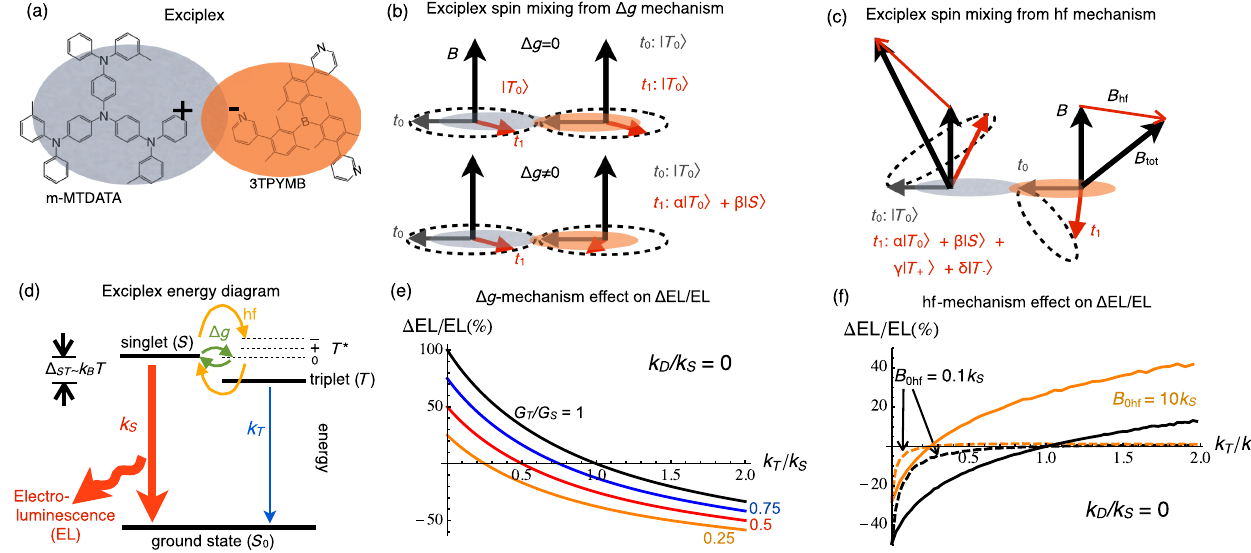
FIG. 1. Exciplexes, Δ g mechanism, and hyperfine mechanism for magnetic field effects. (a) Schematic of the exciplex with m- MTDATA as the donor and 3TPYMB as the acceptor. The electron (hole) wave function is schematically represented by the orange (gray) oval and is overlaid upon the respective chemical structures. (b) Δ g spin mixing between the electron and hole spins (shown to be orthogonal to the applied field B ) which are initiated at time t 0 in the j T 0 i spin configuration. In the top panel, where there is no difference in g factors, the spins remain in their initial configuration. In the lower panel, with nonzero Δ g , the spinor picks up singlet ( j S i ) character over time t 1 . (c) As in (b), but hyperfine spin mixing between electron and hole spins. In this case, spin mixing occurs among all four spin states. (d) Energy diagram of exciplex showing the exchange splitting Δ between the singlet and triplet levels. For efficient TADF, Δ ST ST T . The much quicker singlet recombination (with rate k should be similar in magnitude to the thermal energy k ) is depicted by the thicker B S arrow compared to triplet recombination (with rate k ) and luminescence is assumed only for the singlet recombination. Spin mixing T occurs due to the Δ g mechanism (i.e., transitions between S and the activated T 0 level of T (cid:2) ) and the hyperfine mechanism (i.e., transitions between S and all activated triplet levels of T (cid:2) ). (e) Theoretical calculations for the MEL ¼ Δ EL = EL at large field with the Δ g mechanism 0 ). (f) Theoretical calculations for the MEL ¼ Δ EL = EL from hyperfine spin mixing at large field ( Δ g ¼ 0 ). Increasing either ( B 0 hf ¼ 0 . 25 and black lines G =G =G or B 0 causes the MEL to be more negative for exciplex recombination values. Orange lines are G T S T S ¼ hf 1 . For panels (e) and (f), k =G are G is the exciplex dissociation rate and G is the singlet exciplex generation rate, whereas G is the T S ¼ D S T generation rate for thermally activated triplet exciplexes (see text for additional